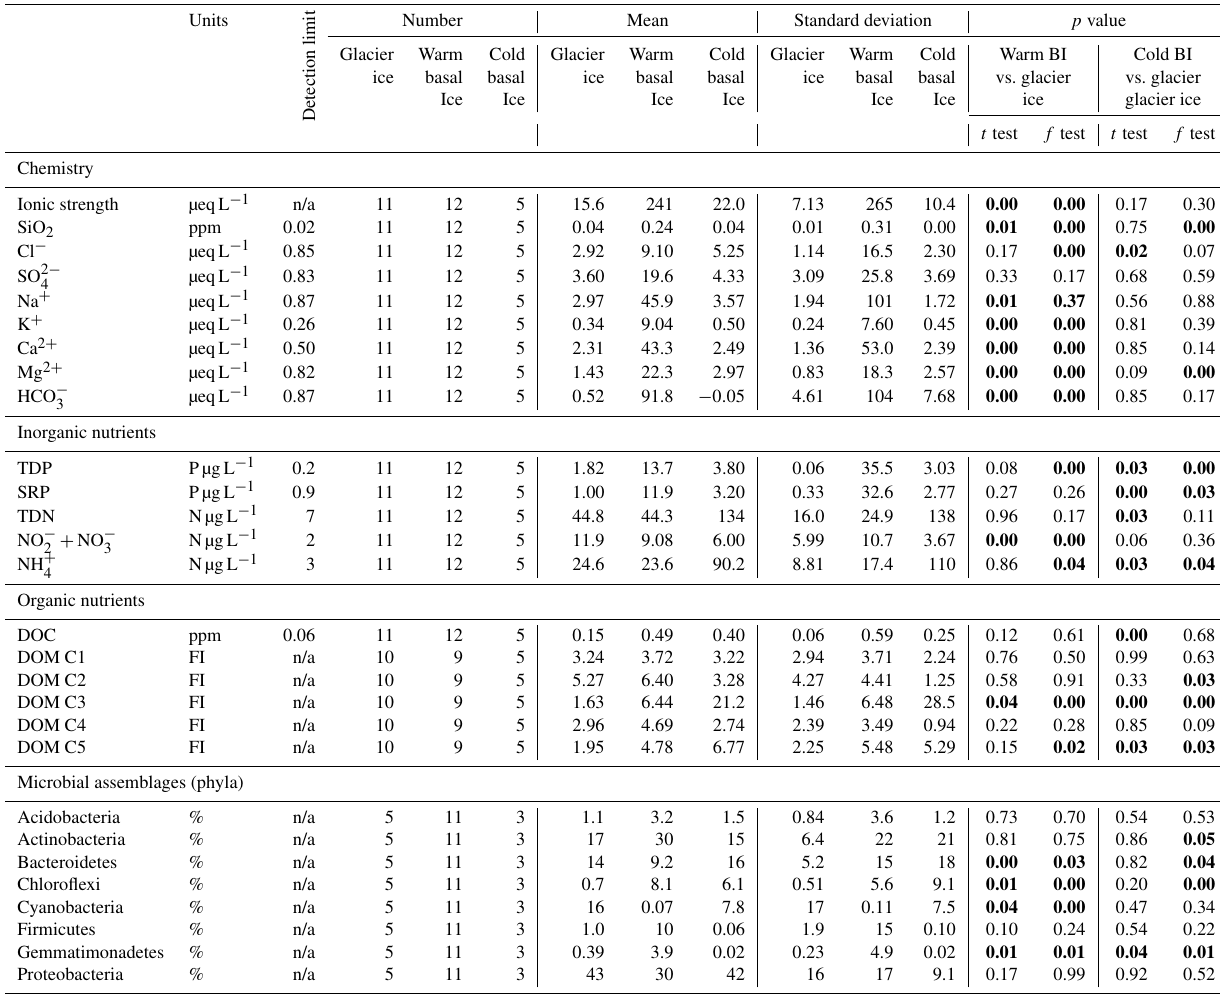
Table 1. Number, mean, and standard deviation of measures of major ions, inorganic nutrients, and DOM components in glacier ice, warm basal ice, and cold basal ice, and statistical tests between warm basal ice and cold basal and glacier ice. The p values that represent significant differences ( p < 0 . 05) are